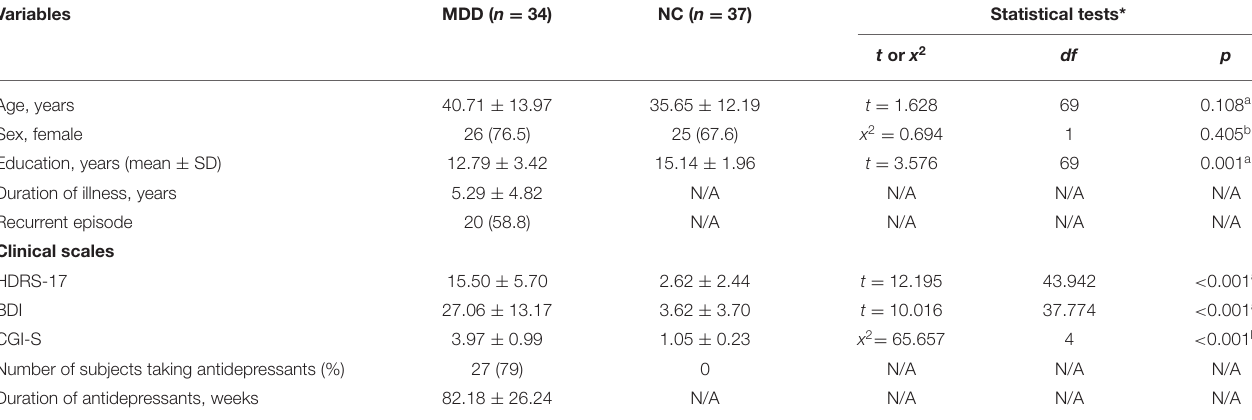
TABLE 1 | Comparison of demographic and clinical information between the MDD and NC